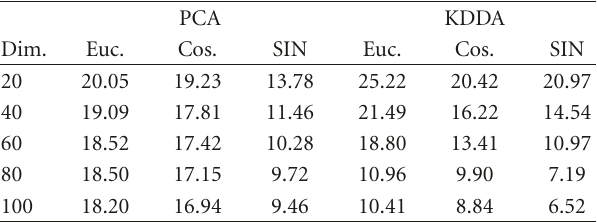
Table 4: Obtained EER (in %) for face verification. PCA KDDA